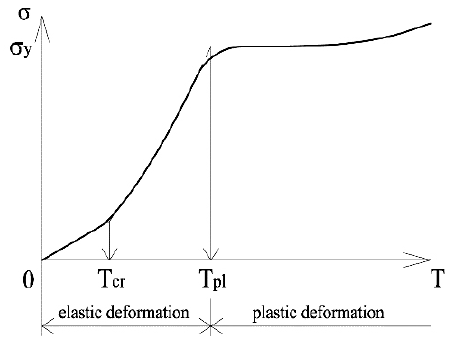
Fig. 12. Typical shear load – the maximal web stress curve This curve has two characteristic points, at which the slope of the curve changes. The first point represents the critical web buckling load ( T ), whereas the second cr point represents load at which the material yield stress in the web is reached, i.e. the plastic deformation in the web plate occurs at load T . Both values for all seven tested pl specimens are given in Table 3, where: